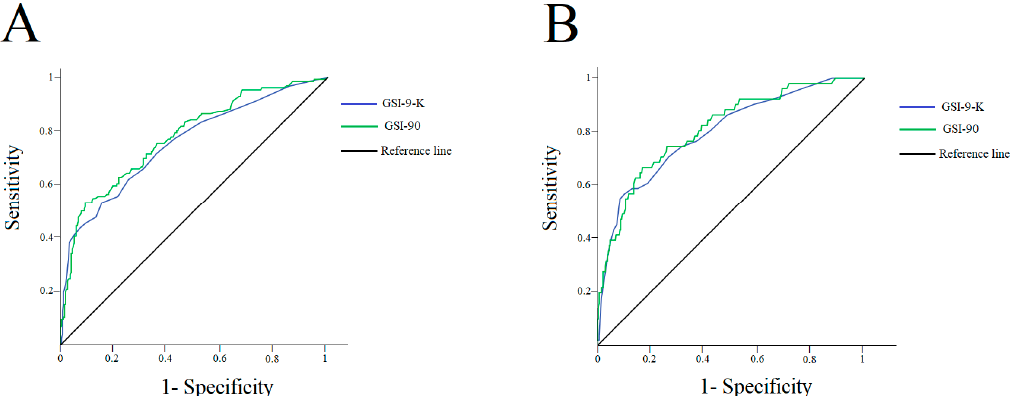
Figure 1. Panel A : ROC curve graph for the ability of the GSI-K-9 and GSI-90 to discriminate individuals with moderate-to-severe levels of binge eating (BES total score ≥ 18) from those without a significant level of binge eating symptoms (BES total score < 18). Panel B : ROC curve graph for the ability of the GSI-K-9 and GSI-90 to discriminate individuals with severe levels of binge eating (BES total score ≥ 27) from those without significant levels of binge eating symptoms (BES total score < 27).